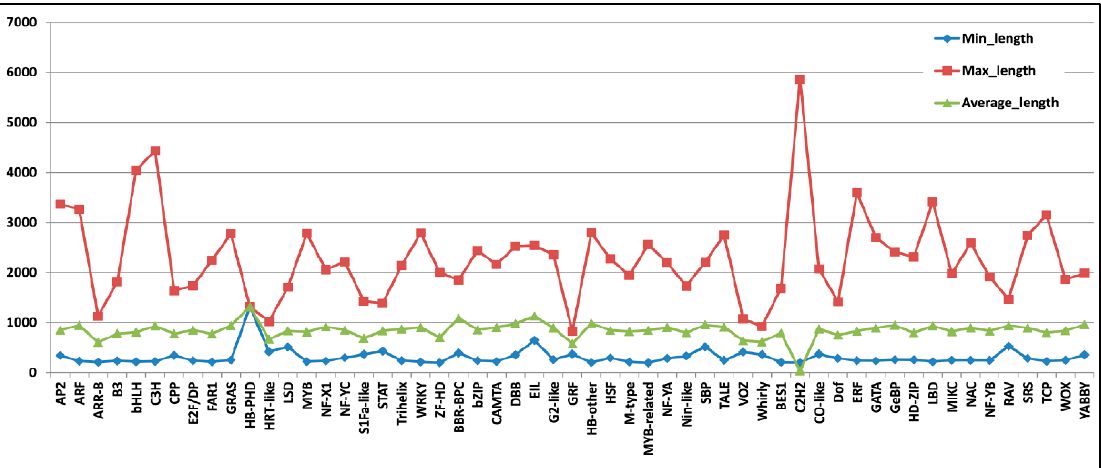
Figure 4. Pie-chart distribution of T. cordifolia 4311 transcripts in to 55 TF categories based on the BlastX search against the PlantTFDB.